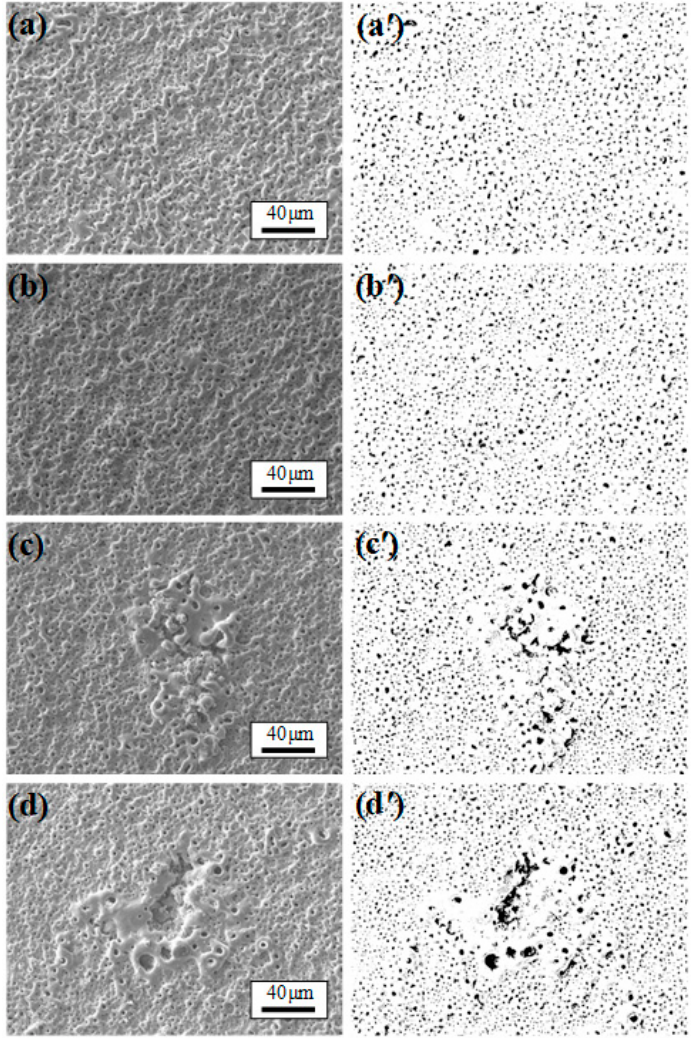
Figure 3. Surface morphologies and distribution of micro pores of MAO coatings under 380 V in different V 2 O 5 contents: 0 g/L ( a , a’ ),0.2 g/L ( b , b’ ), 0.5 g/L ( c , c’ ), and 0.8 g/L ( d , d’ ).